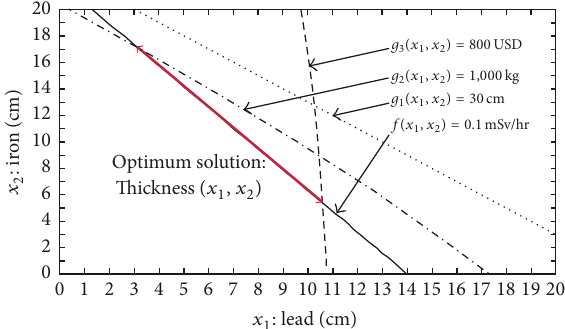
Figure 10: Contour-plotting graph for determination of the optimal double-layer